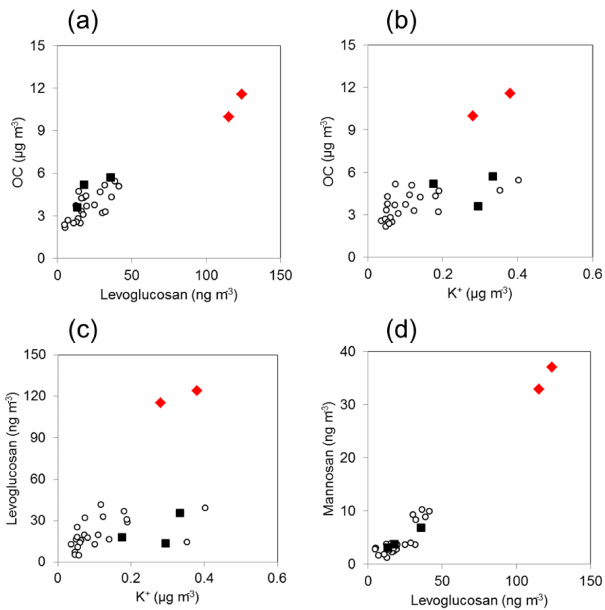
Figure 11. Scatter plots of OC vs. (a) levoglucosan and (b) K + , and levoglucosan versus (c) K + and (d) mannosan between 4 and 31 July 2014. Filled black and red diamonds represent the Chinese haze and Siberian forest fire episodes, respectively. Open black cir- cles represent the remaining sampling days in July